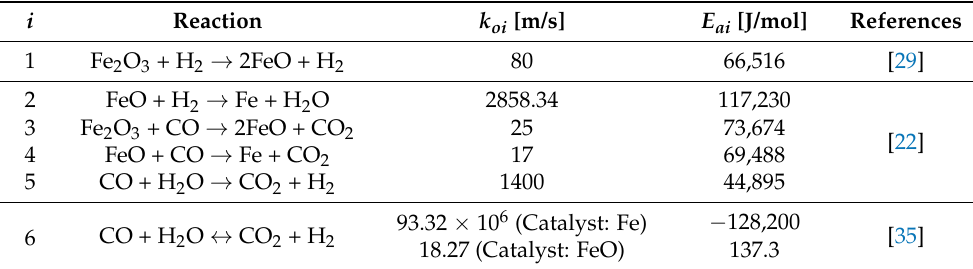
Table 3. Parameters of chemical reaction rates used for the model (between 800 ◦ C & 1100 ◦